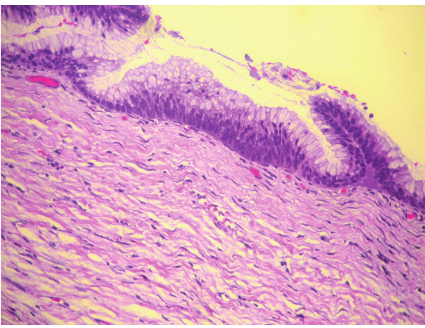
Figure 2: Mucinous cystadenoma of the appendix. Hematoxylin eosin stain.